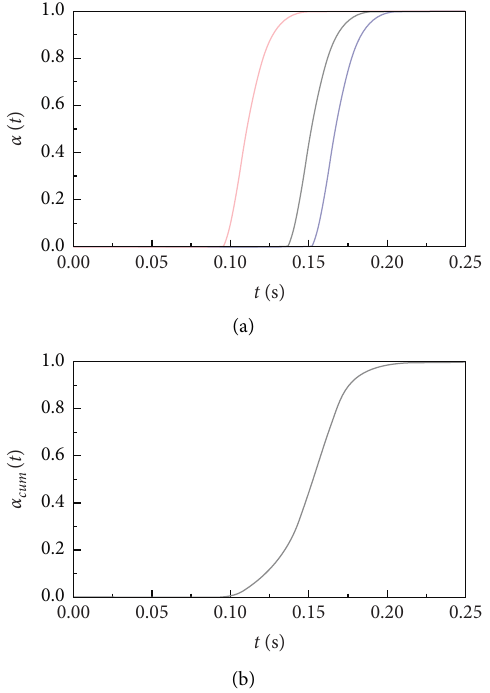
Figure 4: (a) The degree of chemical conversion, α ( t ) , for three particles that are nearest neighbours in the initial configuration and (b) the cumulative degree of chemical conversion, α function of time, t . Data refer to the first simulation described in Table